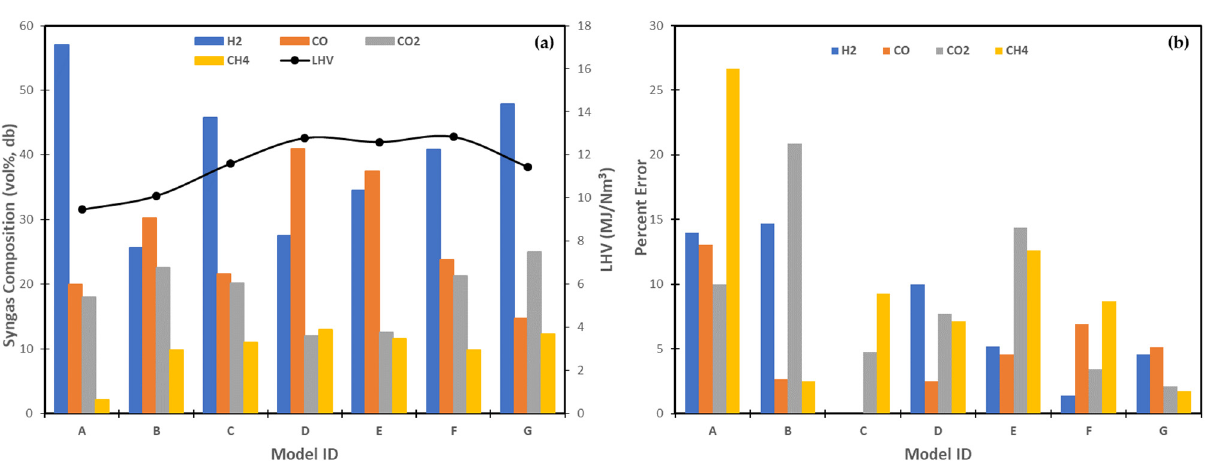
Figure 5 . Aspen Plus models published in the past decade for gasification of woody biomass with steam or combined air and steam as the gasification agent.